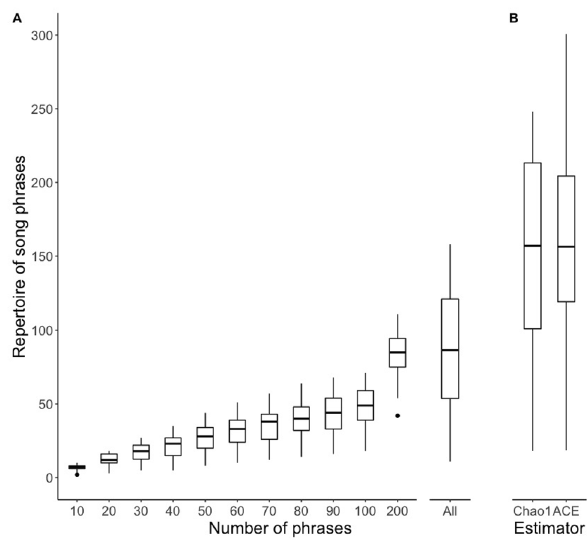
Figure 2. Song phrase repertoires of the Aquatic Warbler males. ( a ) Enumerated phrase repertoire as a function of the number of phrases from the start of a recording. Because the number of song phrases recorded from each male varied, the sample size for the enumerated phrase repertoire was N = 40 for 10–20 phrases, N = 39 for 30–40 phrases, N = 37 for 50–100 phrases, and N = 23 for 200 phrases. The enumerated phrase repertoire based on all phrases recorded (range 25–648) for each bird was calculated for all the 40 males. ( b ) Average phrase repertoire size estimated with the Chao1 and ACE estimators, based on all the 40